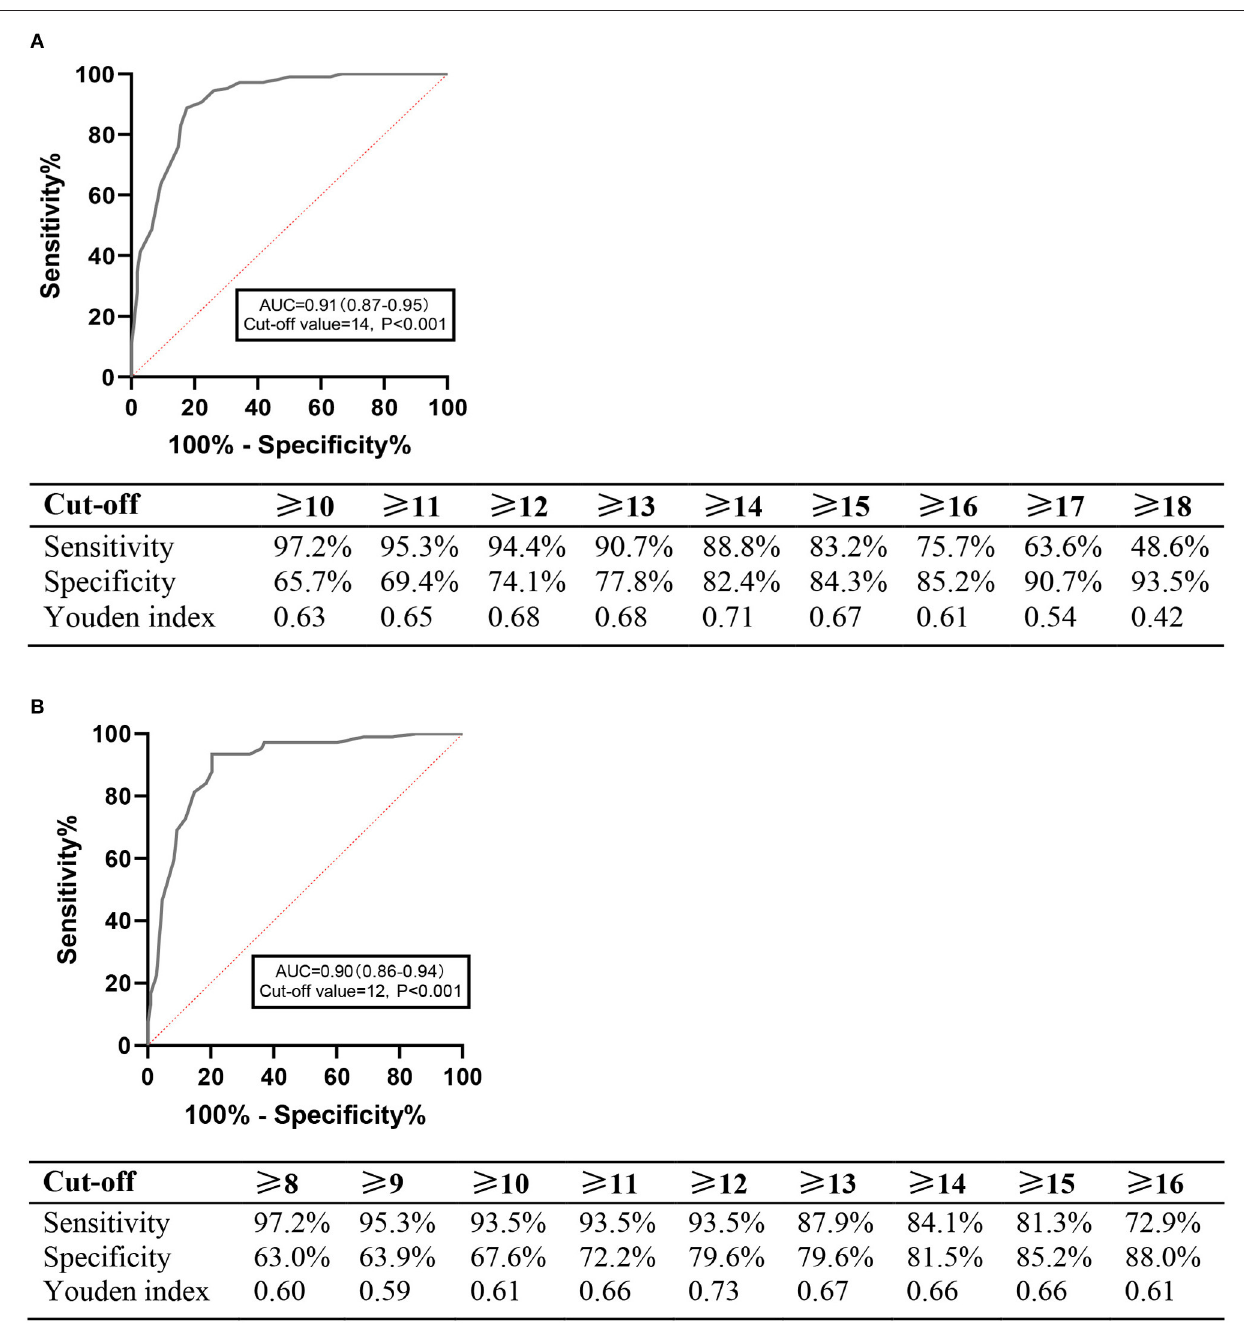
between previous studies on the HCL-32 and HCL-33, including two-factor (17, 18, 31–33), three-factor (34–37) and four-factor structures (38, 39). The discrepancy between studies could be partly due to different study characteristics (e.g., age, gender and severity of illness) and types of rater (e.g., patients for the HCL-33 vs. patients’ carers for the